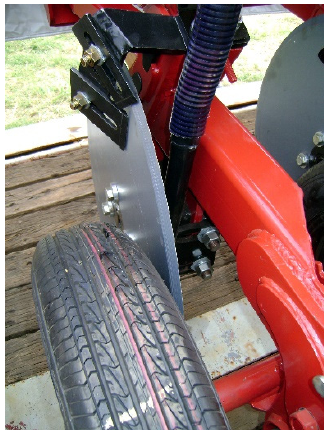
Figure 3. Single inclined disc opener. Seed and fertilizer are delivered behind the disc.